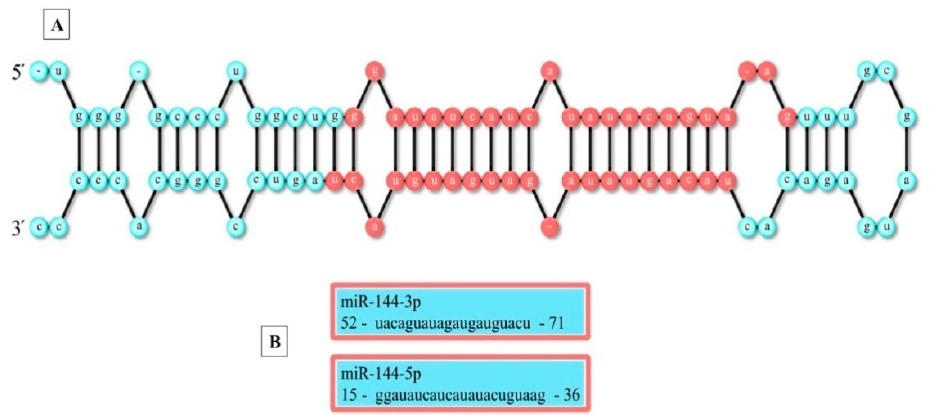
Figure 1. The structure and sequence of miR-144. Note: ( A ) Stem-loop structure of miR-144. ( B ) Two different mature sequences of miR-144.